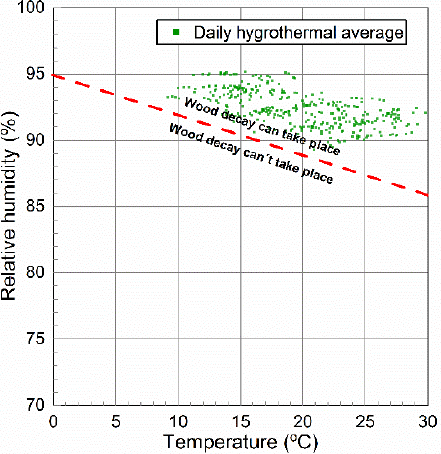
Figure 3. Wood decay assessment based on the WTA 6-8 model.